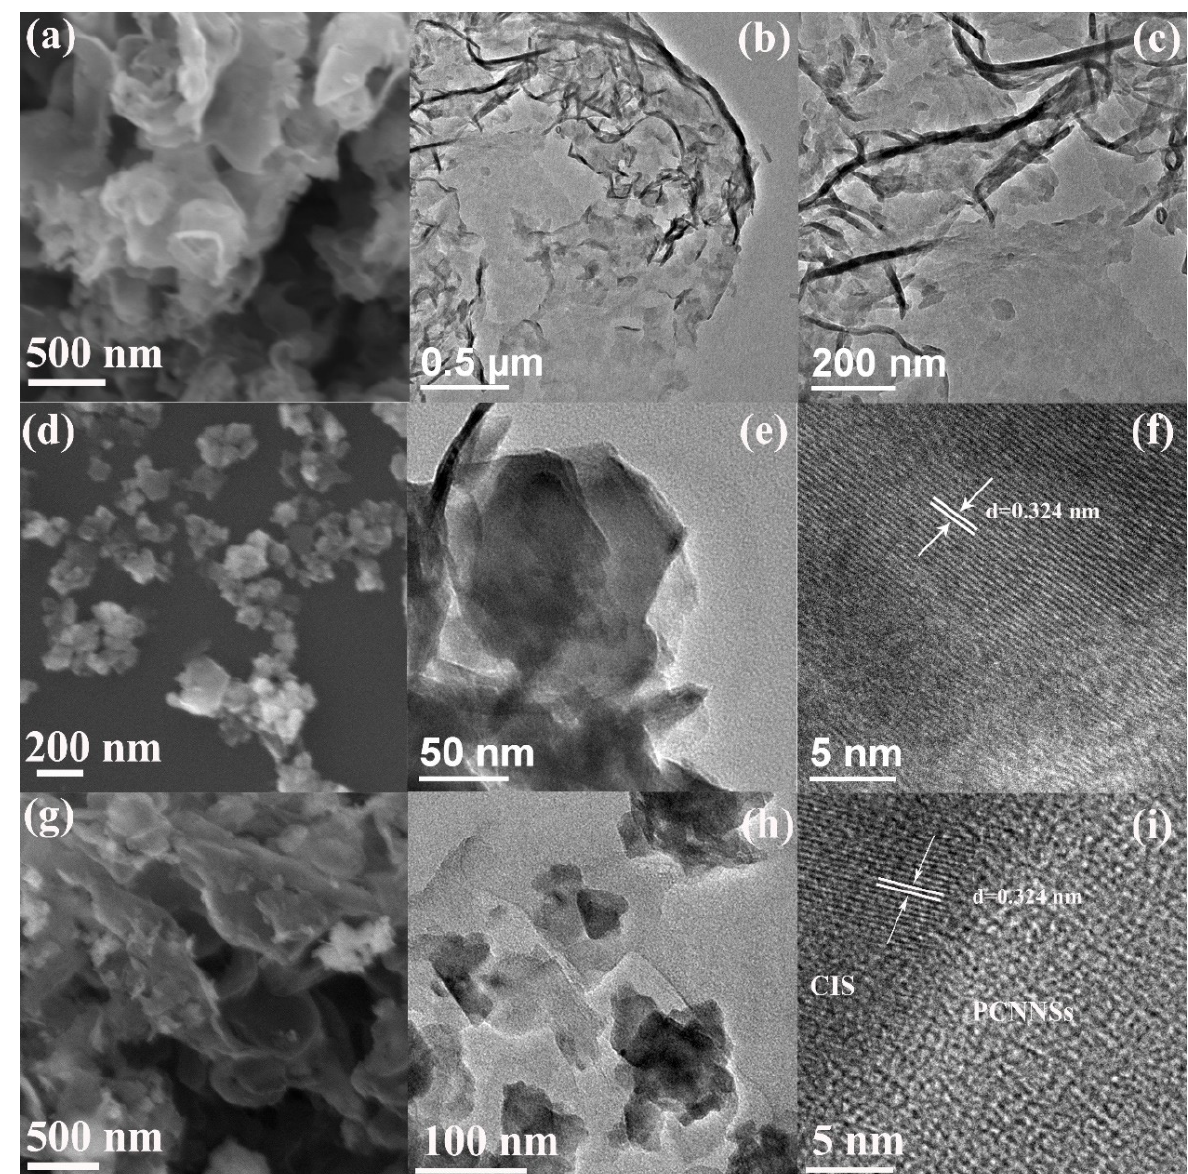
Figure 1. XRD patterns of the fabricated catalysts.